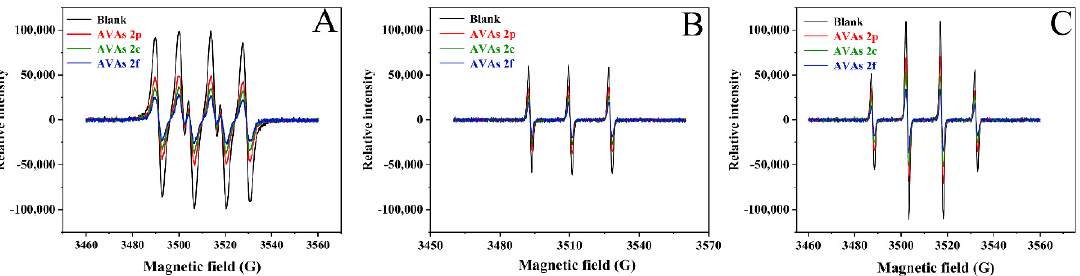
Figure 5. ESR spectrum of spin adducts generated by trapping radicals ·O 2– ( A ), 1 O 2 ( B ), OH ( C